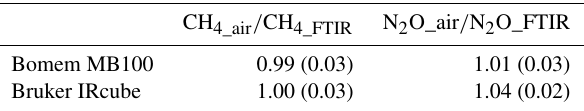
∗ Mean (standard deviation). The measurements were conducted at stable background conditions for 6d at Charlton, Victoria. The pathlength was 100m (two-way path), and measurement height was 1.5m above ground level.